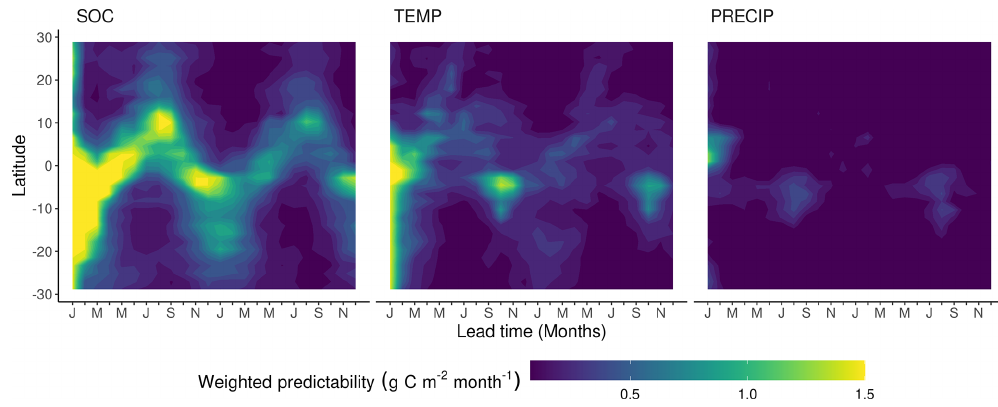
Figure 6. Zonal means of contributing components to the weighted Rh predictability ( wV c ). The contributing components are the pre- dictability of soil organic matter (SOC), air temperature (TEMP), and precipitation (PRECIP).